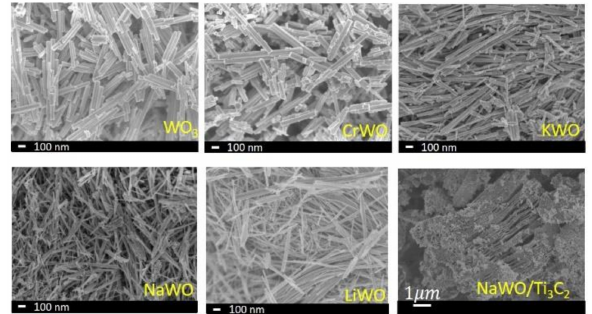
Figure 1. SEM images of WO 3 and